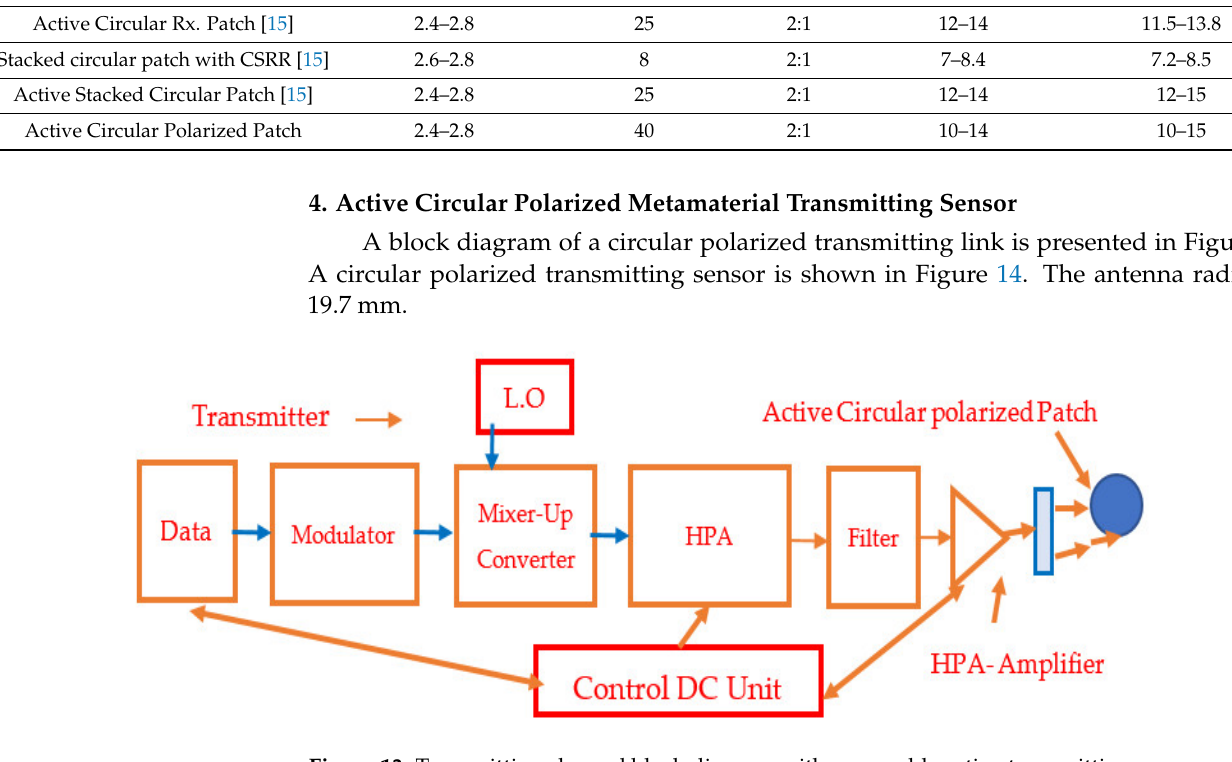
Figure 14. Active Circular Transmitting Patch antenna for Internet of Things (IoT) and 5G Applica- tions. The High Power Amplifier HPA, GaAs MESFET VNA25, and the antenna are assem- bled on the same substrate. The HPA is connected to the branch coupler of the circular polarized sensor. The antenna is matched to the power amplifier by a printed matching circuit. The transmitter is matched to the amplifier by the input matching circuit. The matching circuits, dimensions are less than 23 × 29 mm. The HPA features are listed in Table 7. The HPA S4P parameters are presented in Table 8. The antenna optimized match- ing network is shown in Figure 15a. The antenna bandwidth was improved to 55% for S11 lower than −6 dB. The S11 of the transmitting circular polarized antenna is lower than −9 dB in the frequency range from 1.9 to 3.1 GHz as shown in Figure 15b.